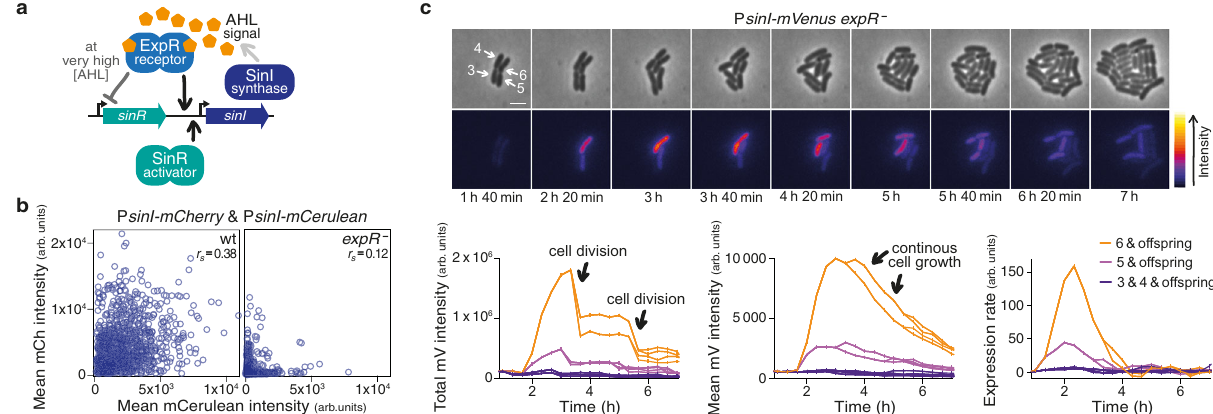
Fig. 1 sinI expression is realized in stochastic pulses. a Simpli fi ed sketch of the regulatory network controlling AHL synthase gene expression in S. meliloti . b Fluorescence intensities from two sinI promoter-reporter gene fusions within individual cells determined by microscopy. Pooled data from 10 (wt) and 12 ( expR − ) colonies, respectively, imaged on 3 different days. Total number of cells analysed: N = 1190 (wt), 1287 ( expR − ). r s , Spearman ’ s correlation coef fi cient; P (two-tailed) <0.0001 for both data sets. See Supplementary Fig. 2a for raw images and details on the construct, Supplementary Fig. 2b for con fi rmation from an alternative construct. c (Top) Phase contrast and fl uorescence images from a microscopy time lapse of an expR − microcolony carrying a P sinI - mVenus fusion, and the ‘ red fi re ’ lookup table applied to the fl uorescence images. Data representative of 9 colonies imaged on 3 different days; scale bar, 2 µ m. (Bottom) For cells #5 and #6, both total and mean fl uorescence intensities fi rst increase. Total fl uorescence then drops with cell divisions and stays almost constant in between, while mean fl uorescence constantly decreases with cell growth. Gene expression rate is calculated as the change in mean fl uorescence intensity over time; peaks in gene expression rate are broadened by the regression involved in the calculation. See ‘ Methods ’ and Supplementary Fig. 3a for details and further